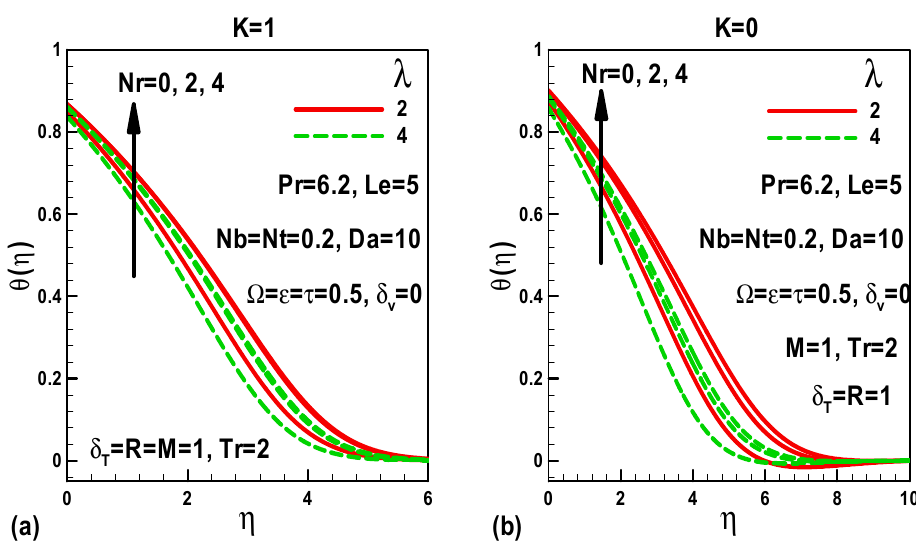
Figure 5. Effects of buoyancy ratio and mixed convection parameters on dimensionless temperature ( a ) with pressure gradient and ( b ) without pressure gradient.